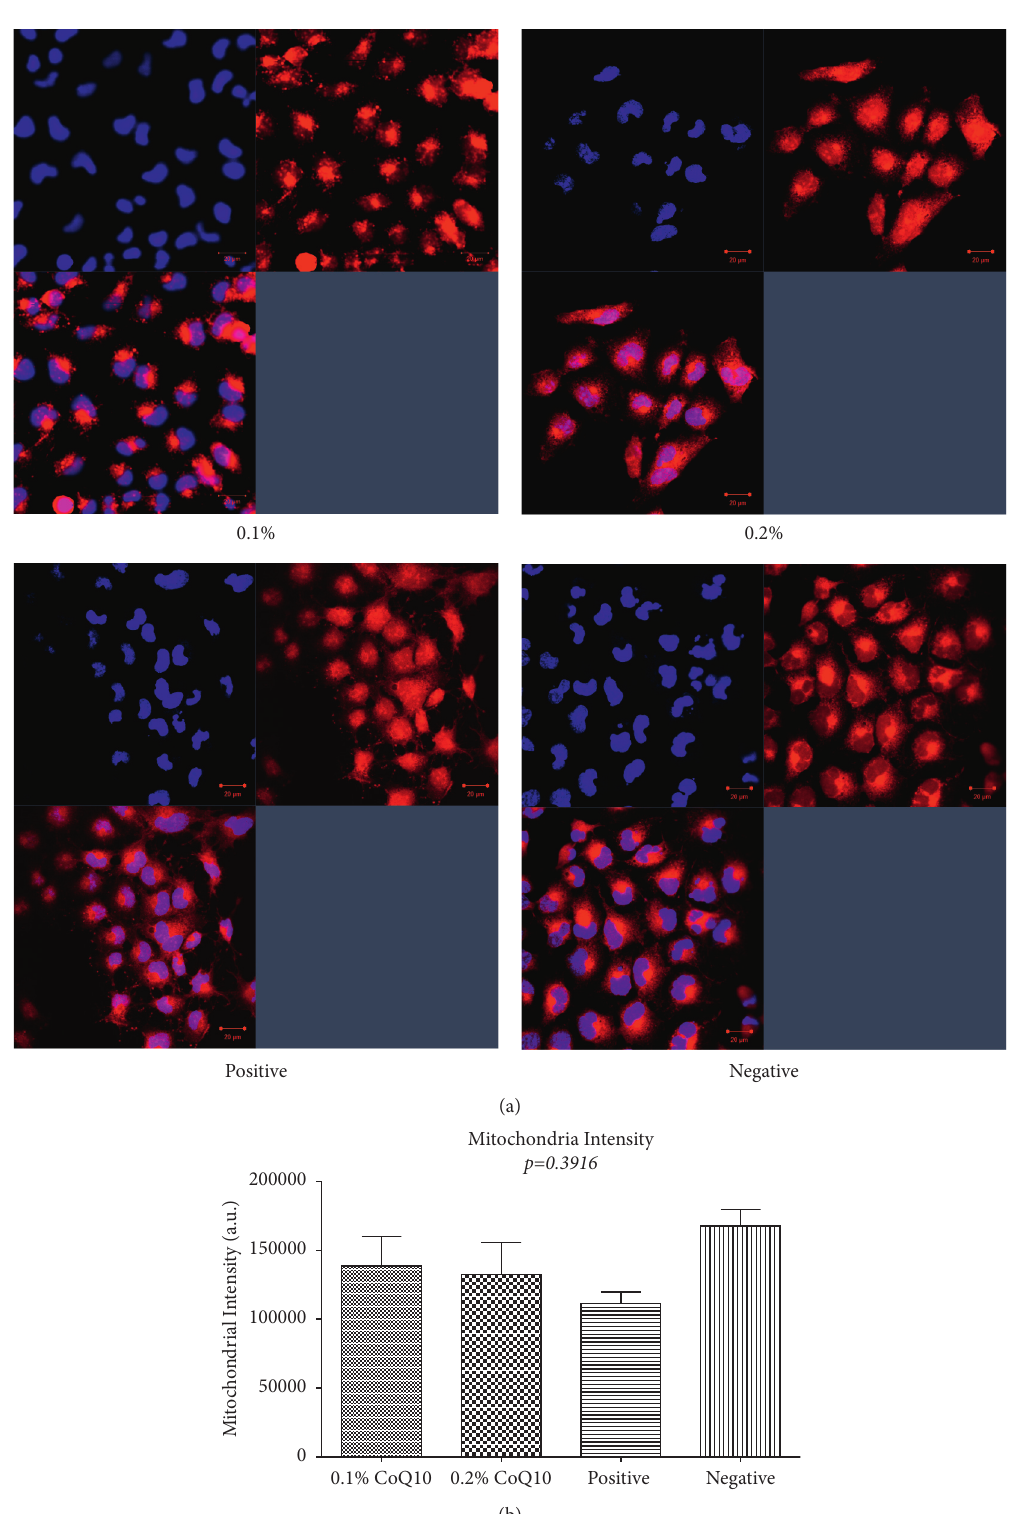
Figure 4: (a) Confocal microscopic images of cells stained with MitoTracker mitochondrial stain at different concentrations of CoQ10. (b) Graphical representation of mitochondrial intensity